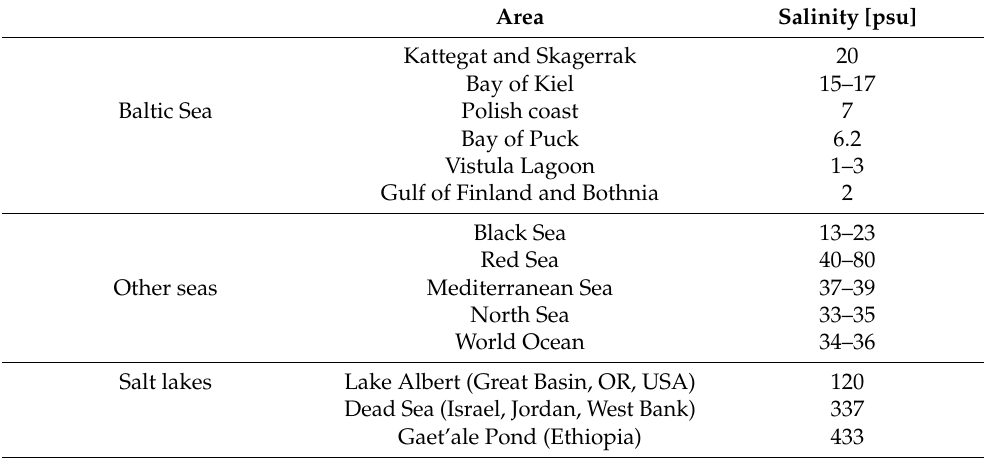
Figure 1. Location of sound speed in water and depth measurements: in Gda´nsk (A) and Gdynia (B). Table 1. Salinity of seas and